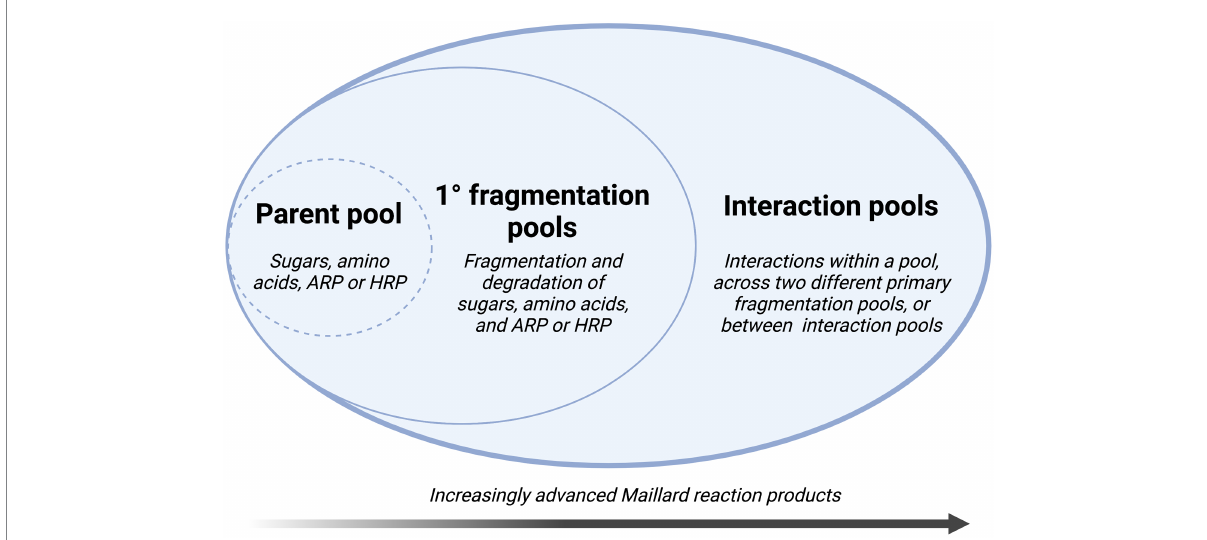
FIGURE 3 Conceptual framework for the Maillard reaction based on the formation and interaction of “chemical pools,” adapted from Yaylayan (1997) (ARP, Amadori rearrangement product; HRP, Heyns rearrangement